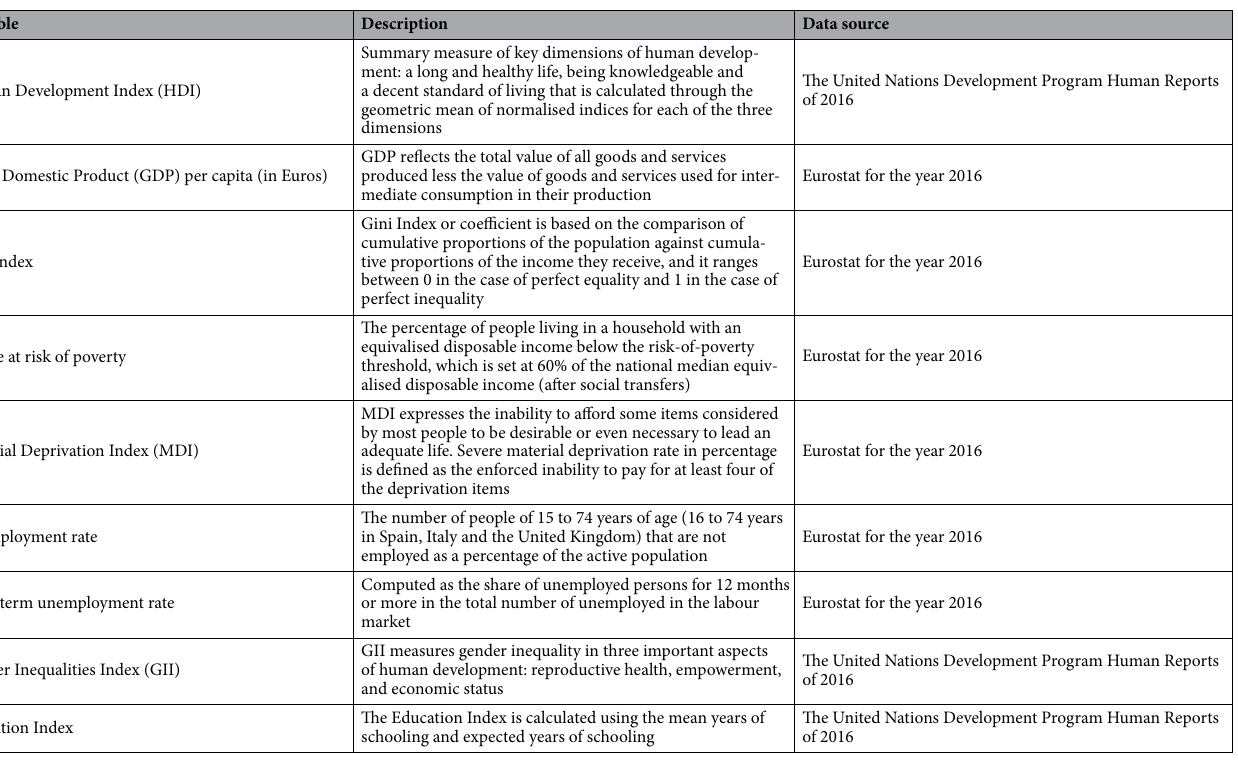
Table 1. Summary of socioeconomic status (SES) indicators (description and data